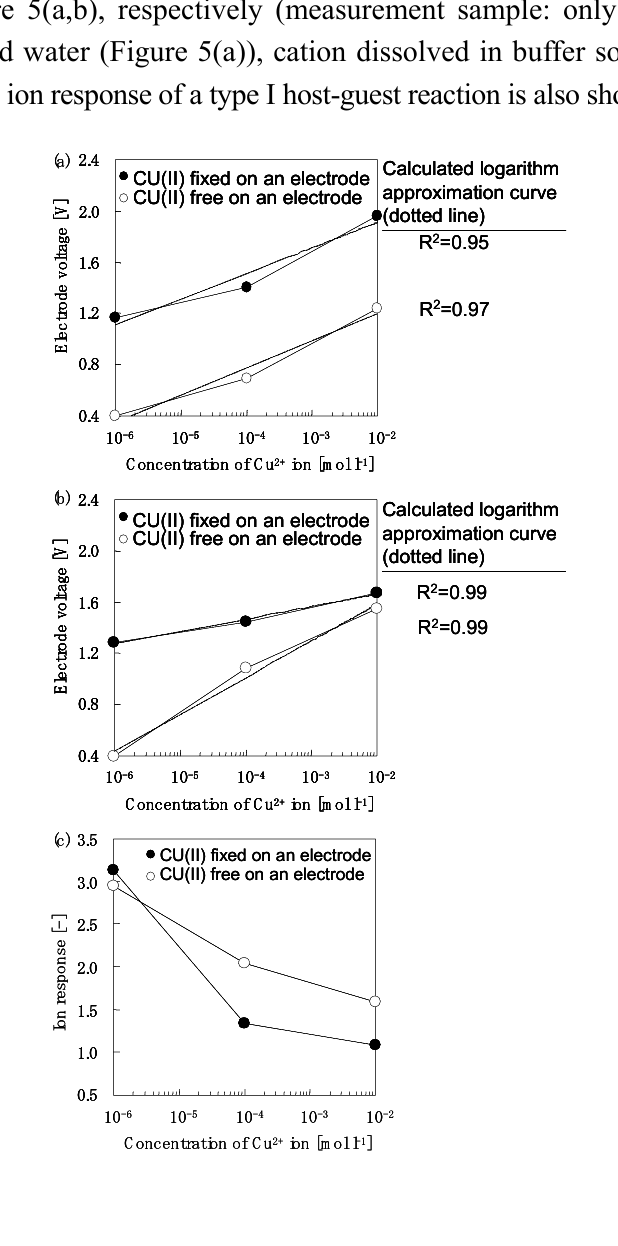
Figure 5. Typical detection voltage of a type I host-guest reaction; group of electrodes that show a positive response. Detection of Cu 2+ by CU(II) adsorbed on an electrode surface